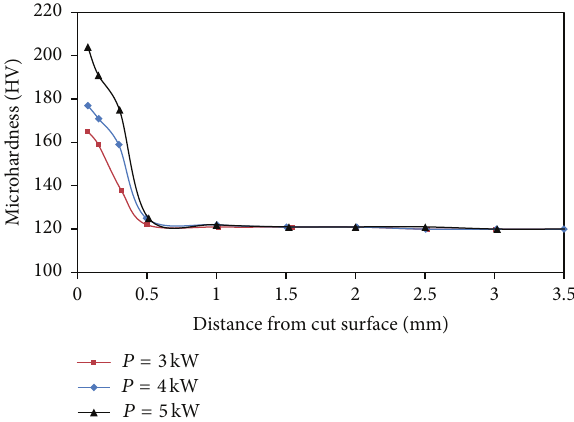
Figure 15: Effect of laser power on HAZ